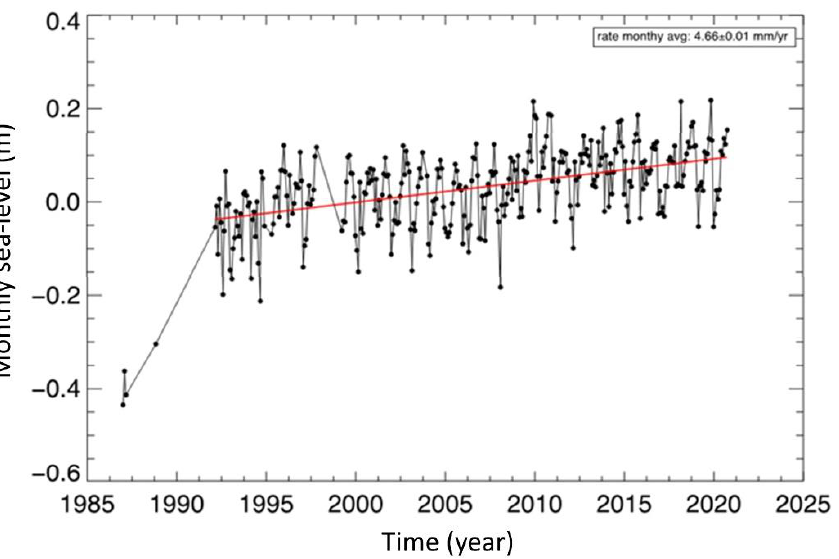
Figure 5. Monthly sea-level at the tide gauge station of Catania in the time span 1986–2020. The linear trend (red line), calculated in the time interval 1992–2020, corresponds to a rate of 4.66 mm/year. Recordings between 1986 and 1992 have been excluded in the analysis due to a relocation of the